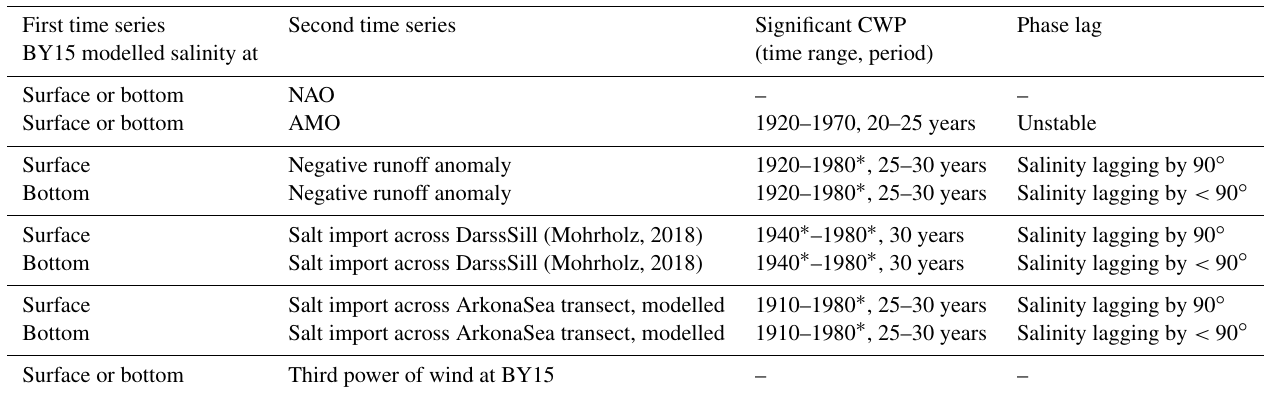
Figure 15. Common wavelet power between salt import across selected transects and normalized annual runoff into the Baltic Sea. T ˆ chosen as time series for salt import across DarssSill and DrogdenSill transects, while T highsal ,t is chosen across ArkonaSea and StolpeChan- nel. White contours indicate that the WA or CWP is significant at the 95% confidence level with respect to a random shuffling of the annual means of the runoff. Arrows indicate relative phase: → : in phase; ↓ : runoff leading salt import by 90 ◦ . Thick arrows indicate phase stability (wavelet coherence > 0.95). Table 2. Summary of the findings of the wavelet coherence